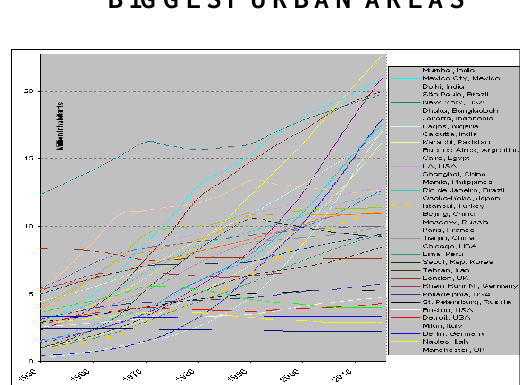
Figure 18: Population growth in the 25 biggest cities (except Tokyo) or agglomerations in the world with included trend- analyses. (Data from UN 2004 in: UN - World Urbanization